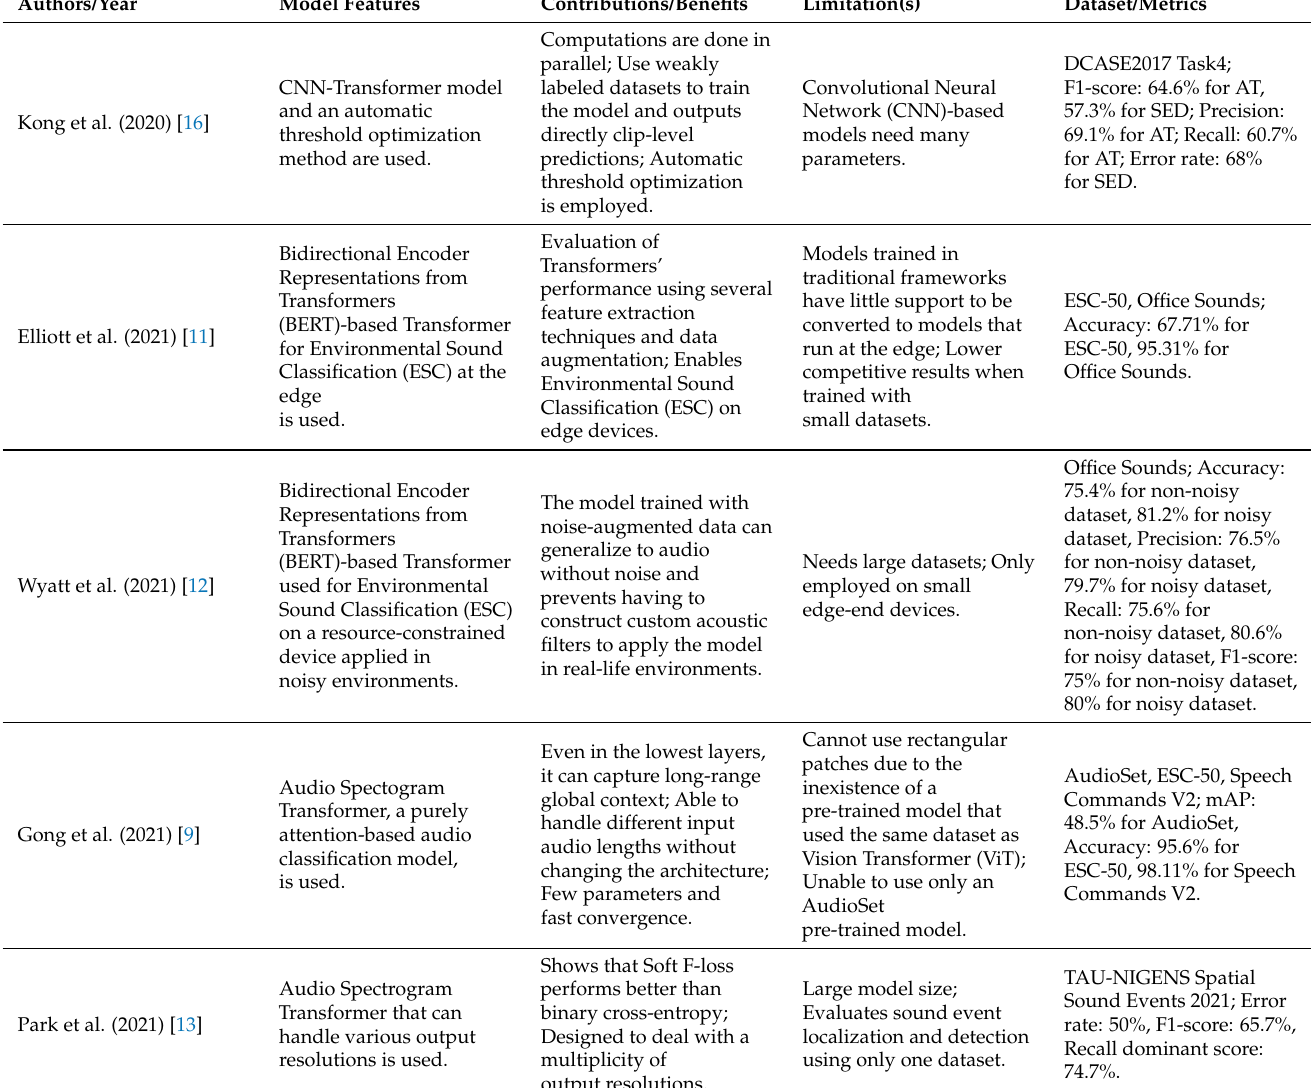
Table 2. Resume of the research articles found on audio classification using